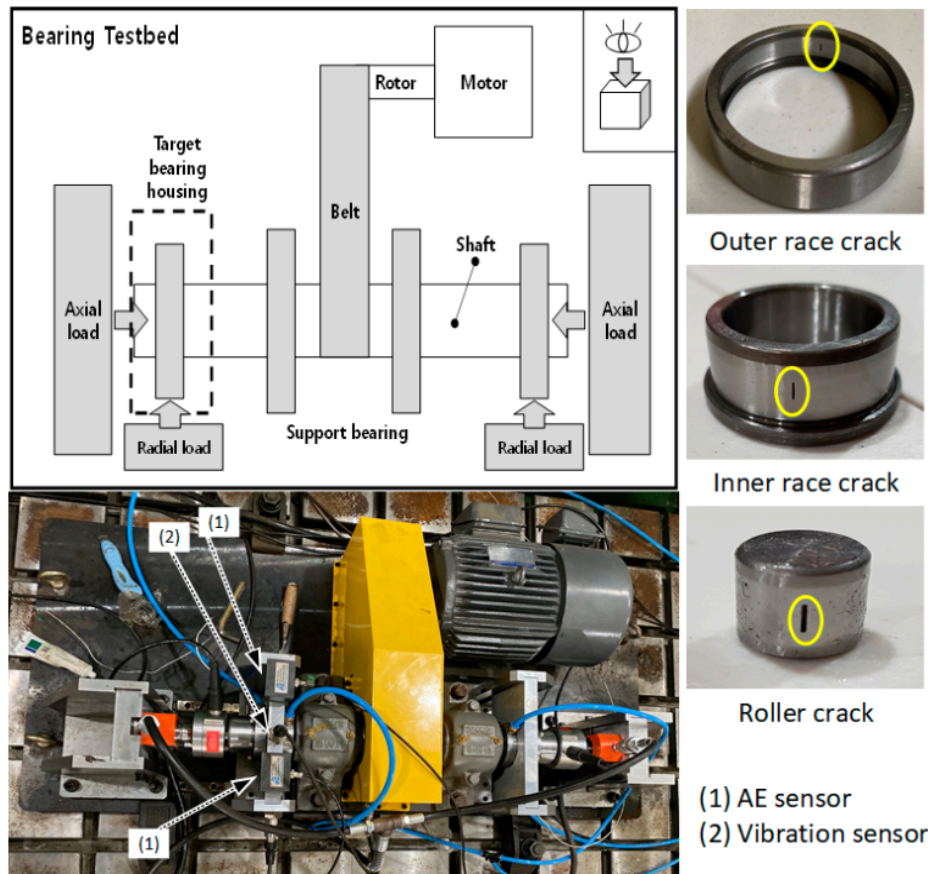
Figure 1. Structure of the bearing testbed setup.